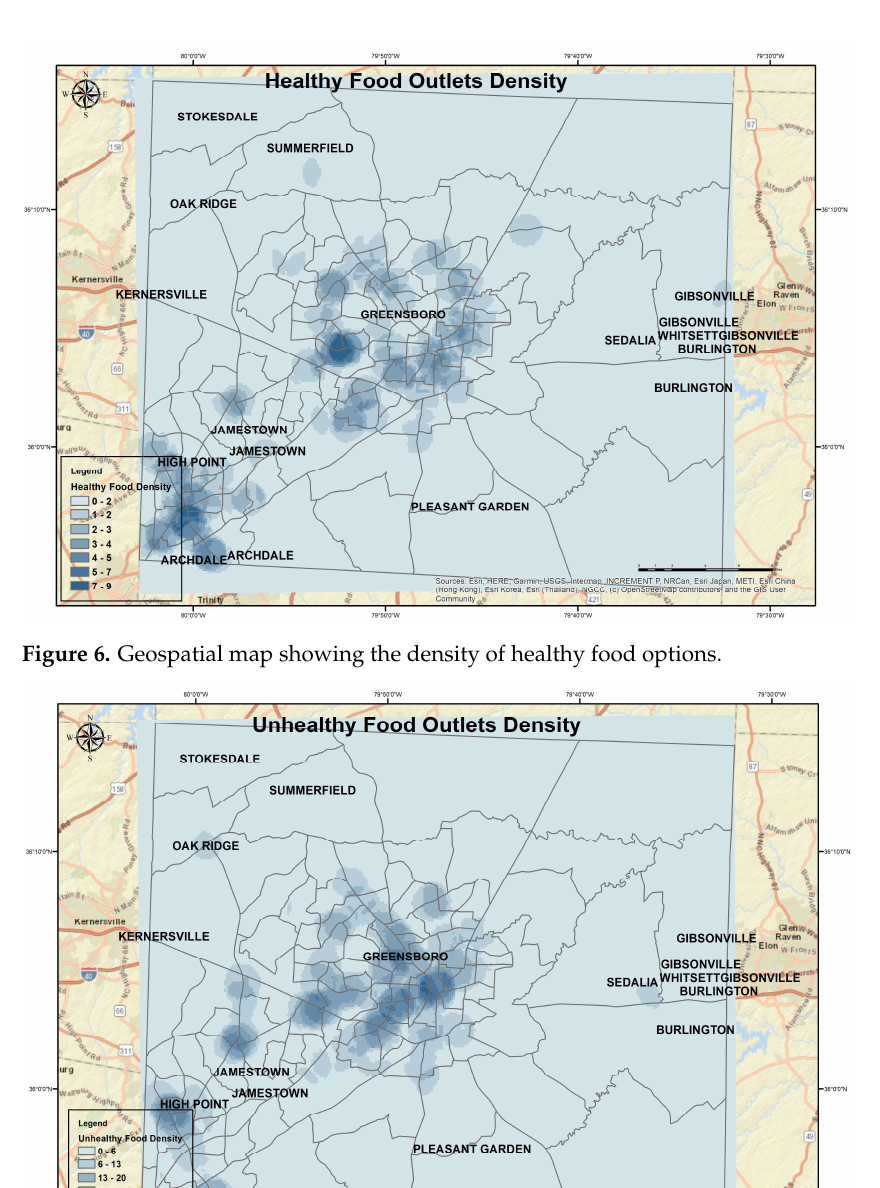
Figure 7. Geospatial map showing the density of unhealthy food